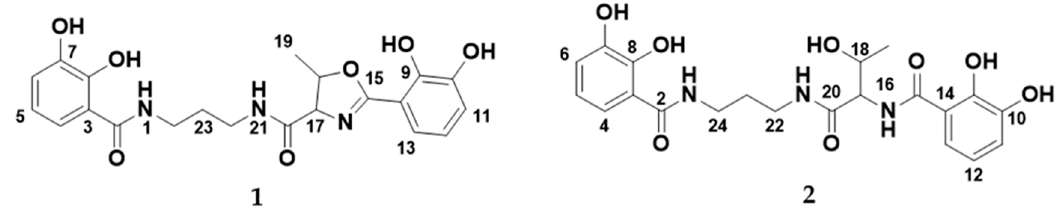
Figure 1. The structures of serratiochelin A ( 1 ) and C ( 2 ).